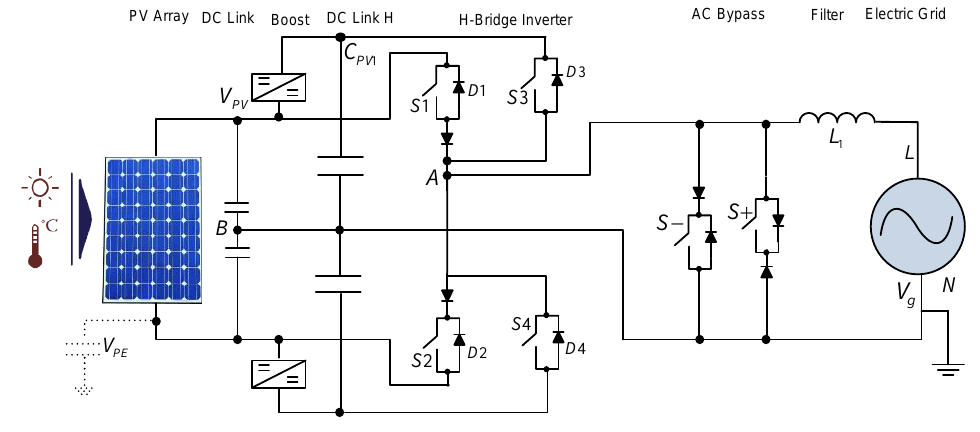
Figure 11. Schematic diagram of the REFU inverter [43,56].